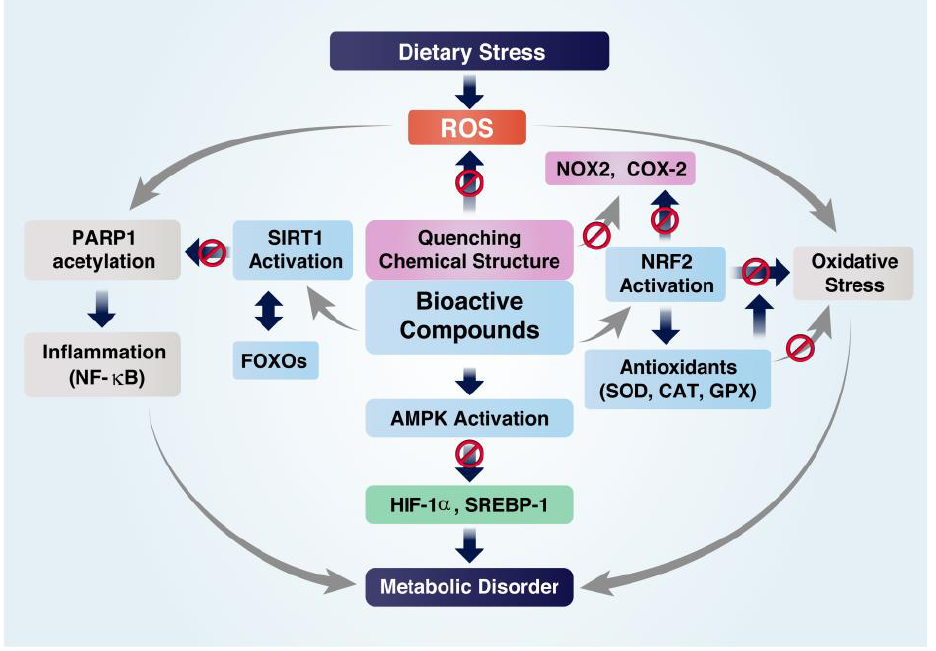
Figure 1. Role of bioactive compounds (BCs) in dietary stress-induced inflammation, oxidative stress, and metabolic disturbances. The role of BCs in dietary stress can be divided into two categories. One is directly scavenging or quenching reactive radicals, such as ROS, due to their conjugated double- bond chemical structure. The other role is to activate biological systems through the activation of the enzyme, SIRT1, and the transcription factor, NRF2. The function of SIRT1 is to activate forkhead box protein O (FOXOs) while inactivating NF- κ B to suppress inflammation. BC-induced NRF2 activation prevents oxidative stress by activating antioxidants, including superoxide dismutase (SOD), catalase (CAT), and glutathione peroxidase (GPX). BCs prevent inflammation, oxidative stress, and metabolic disturbances through the activation of SIRT1 and